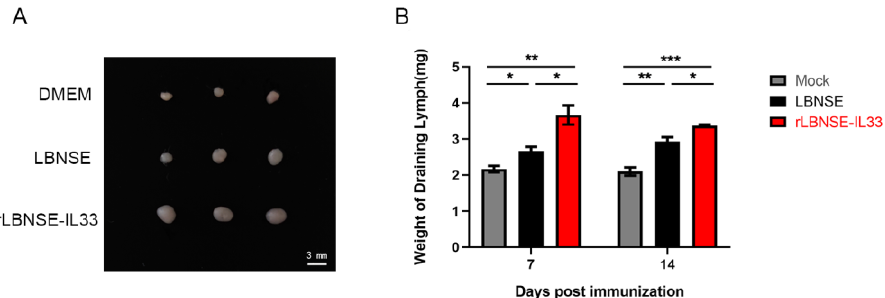
Figure 4. Overexpression of IL-33 in rRABV facilitated the growth and development of draining LNs. The inguinal LNs were collected from mice i.m. injected respectively with LBNSE (10 6 FFU), rLBNSE-IL33 (10 6 FFU), and DMEM at 7 and 14 dpi. The sizes ( A ) and weights ( B ) of these LNs were measured. The standard error (SE, n = 3) was illustrated by error bars, and the data were analyzed by unpaired two-tailed t -test. Significant differences between groups were indicated at three levels: *, p < 0.05; **, p < 0.01; and ***, p < 0.001.